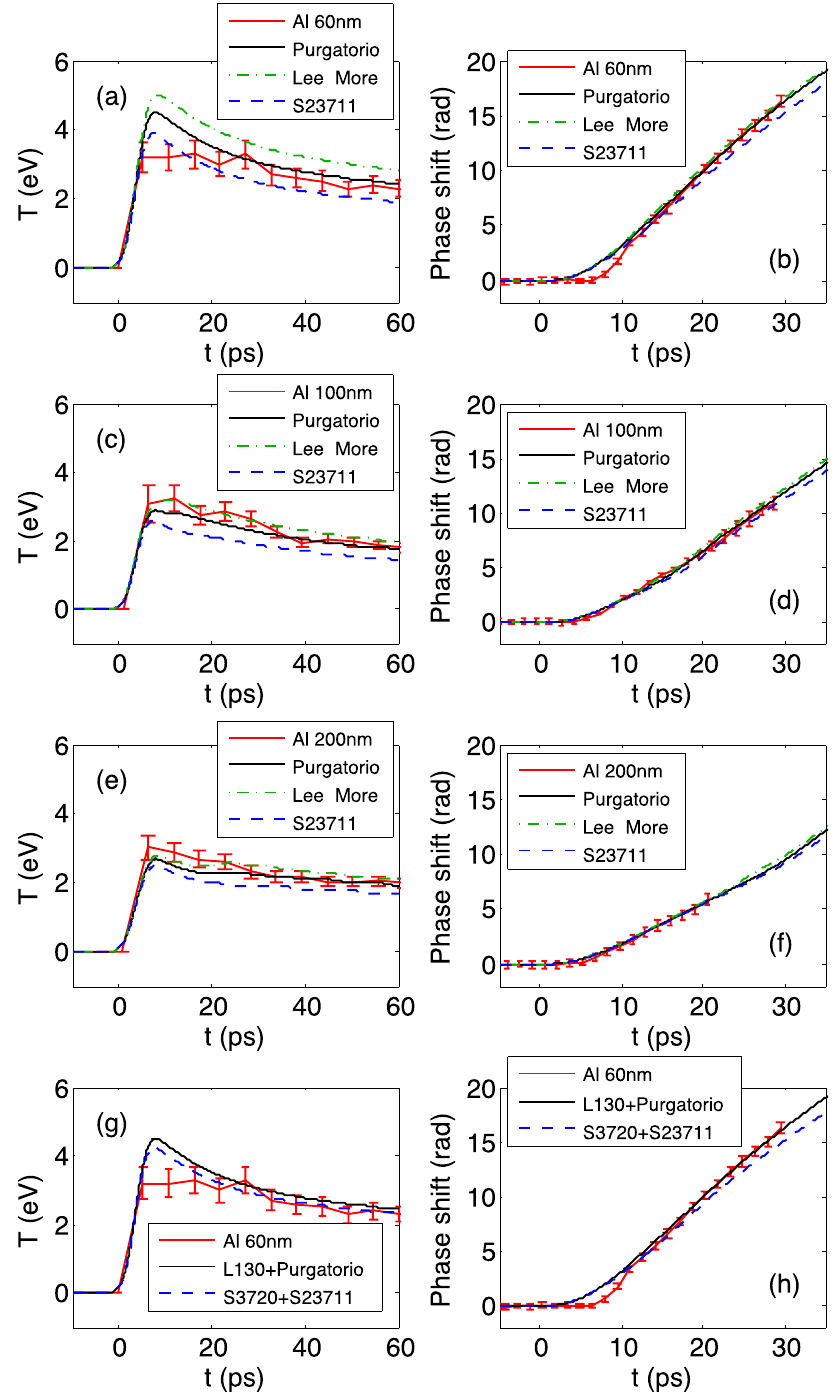
Figure 4. Comparison of 100 nm Au + 60 nm ( a ) /100 nm ( c ) /200 nm ( e ) Al SOP data with HYDRA simulations using L130 for Al EOS, Purgatorio, Lee-More and Sesame 23711 for Al thermal conductivity. ( b , d , e ) are corresponding comparisons with the FDI data. ( g , h ) are 100 nm Au + 60 nm Al data and simulations including Sesame 3720 for Al EOS and Sesame 23711 for Al thermal